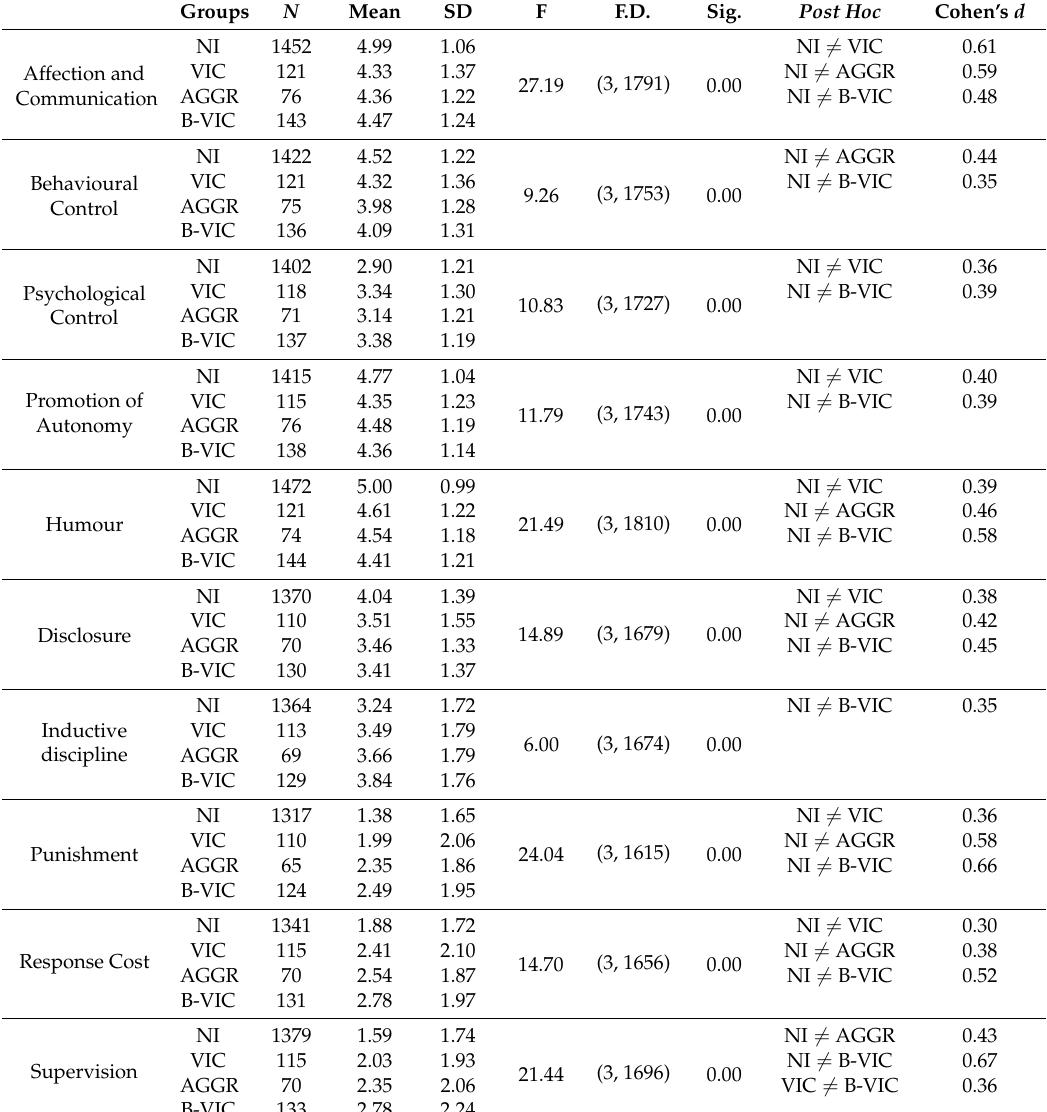
Table 4. ANOVA to determine the differences in parenting practices of father according to the role of involvement in